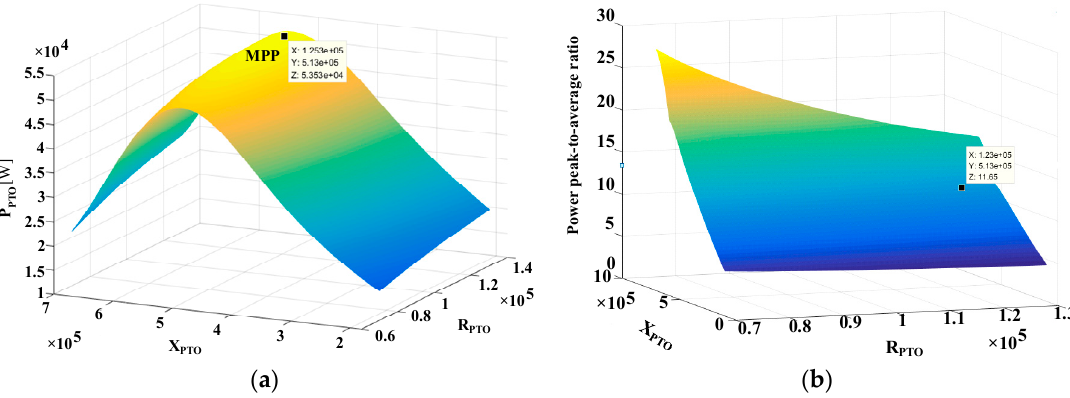
Figure 5. Average power and power peak-to-average ratio of the WEC under different damping and stiffness coefficients, ( a ) average power ( b ) power peak-to-average ratio.